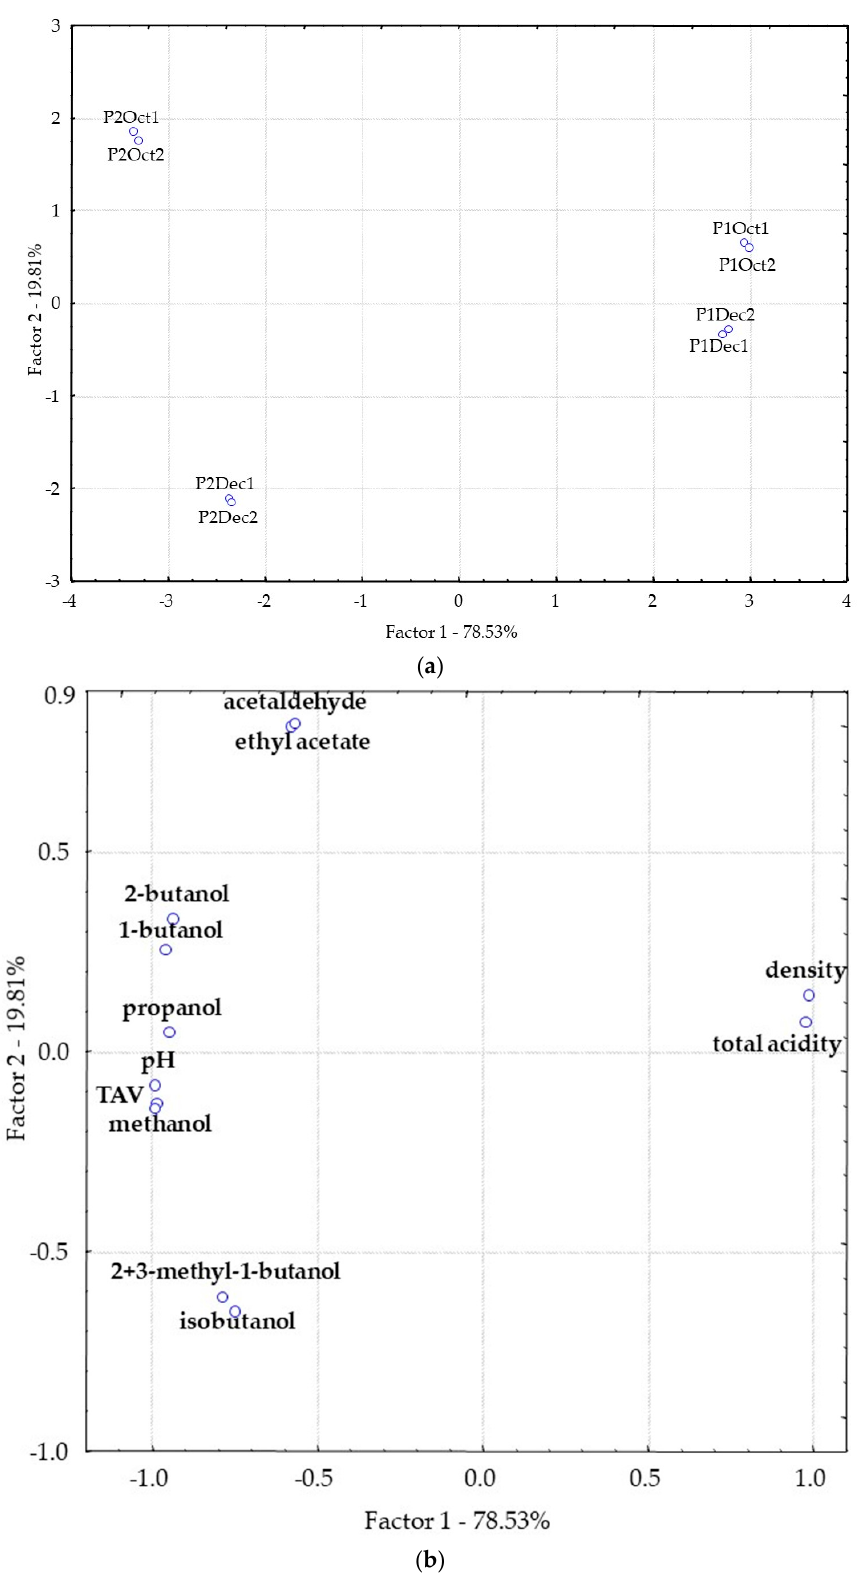
Figure 2. Plot of the distillate samples ( a ) and the variables ( b ) in the plane formed by the two first components from the PCA. Replicates are identified by numbers 1 or 2 after the sample code.